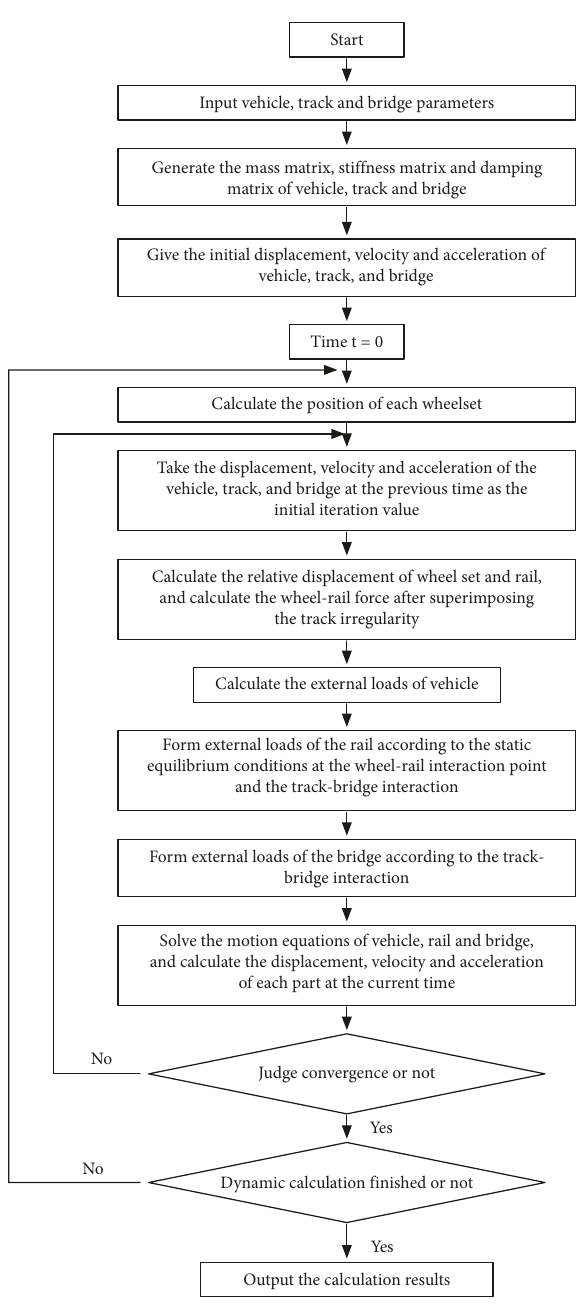
Figure 8: Solving process of the motion equation of the vehicle-track-bridge coupled